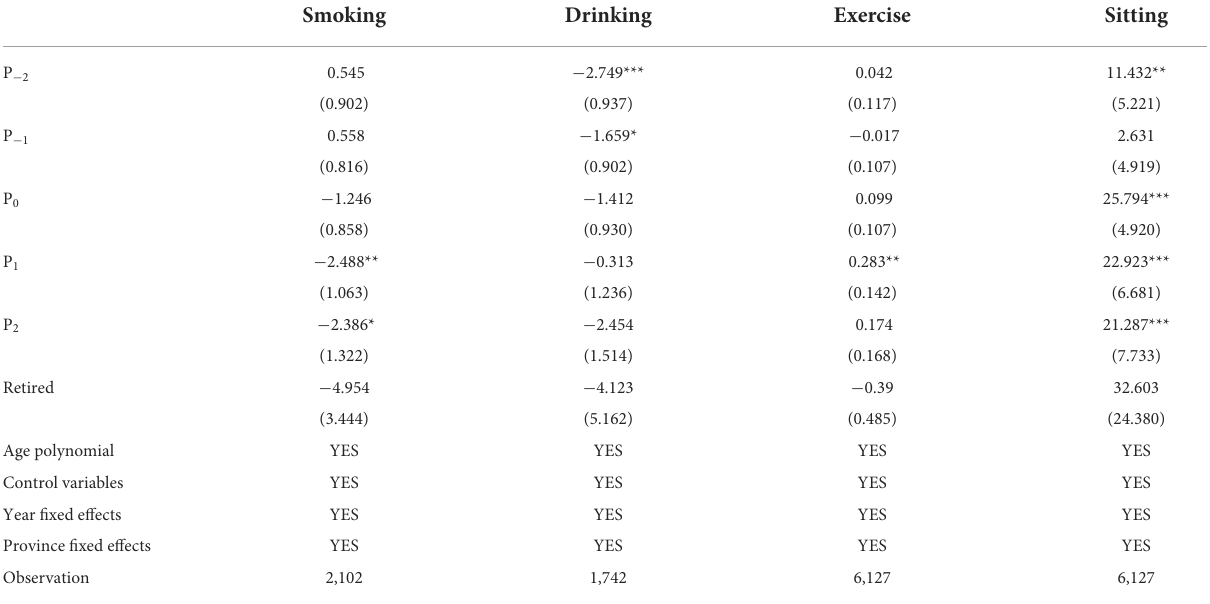
TABLE 10 Results of the time-varying